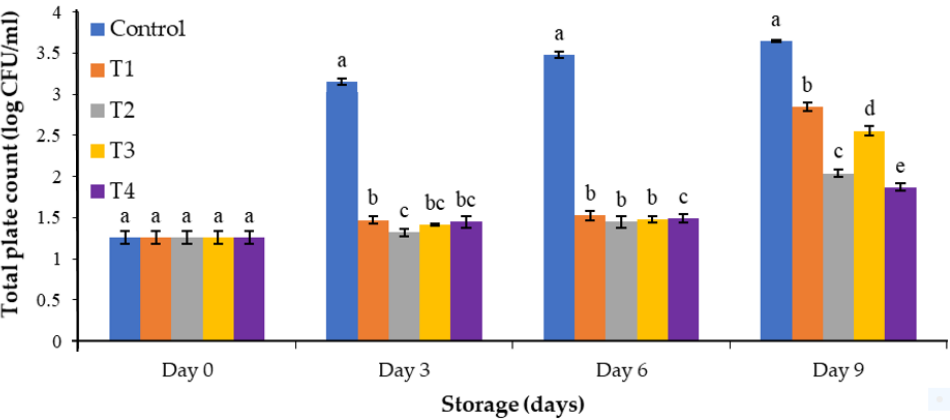
Figure 6. Microbial count of guava fruits at different maturity stages. Different lowercase letters (a – e) within the same group represent significant differences based on Tukey ’ s honest significance test ( p < 0.05). For sample codes, refer to Table 2.